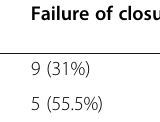
Table 5 Medical treatment of HSPDA group HSPDA ( N =